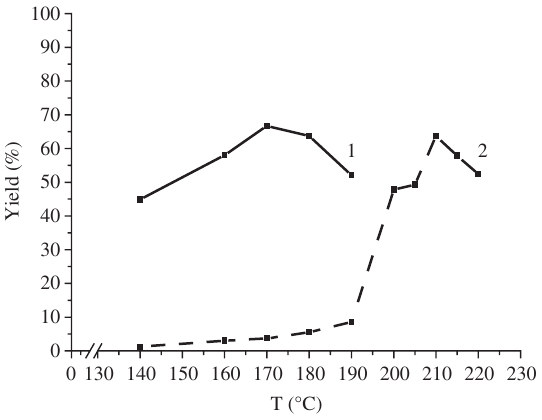
Figure 2: Yield of hydroxybenzoic acids versus temperature (potas- = 10 atm and τ = 7 h): (1) o-hydroxybenzoic sium ethyl carbonate; P co 2 acid and (2) p-hydroxybenzoic acid.